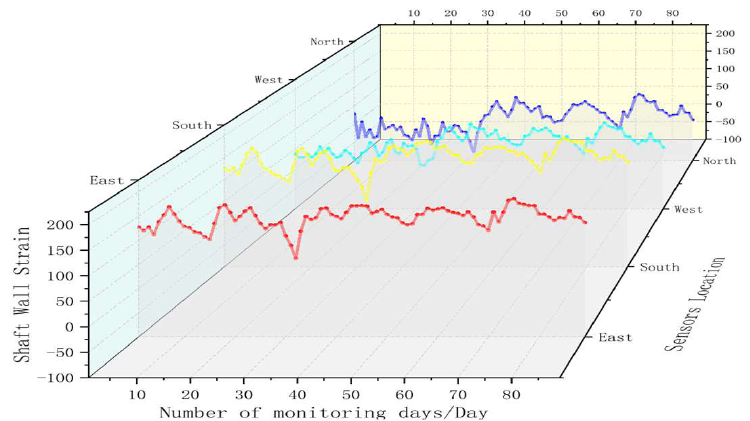
Figure 10. The FBG sensing strain diagram (579 m).